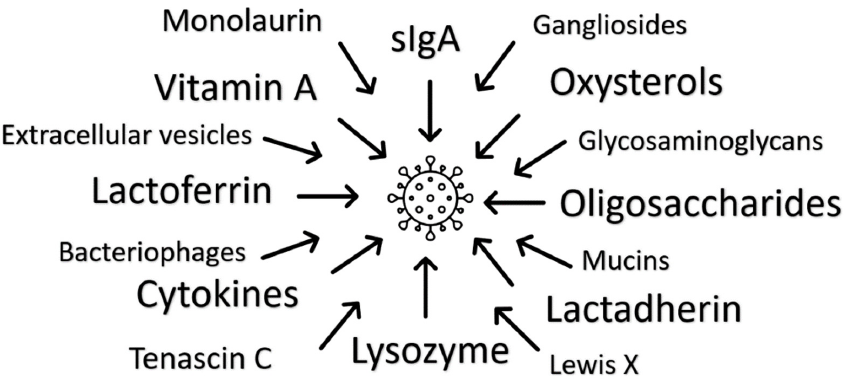
Figure 1. Multiple antiviral mechanisms of human milk have been identified. There is presumed individual and additional multiplicative functionality, with redundancy indicating the significance of milk’s immune function.